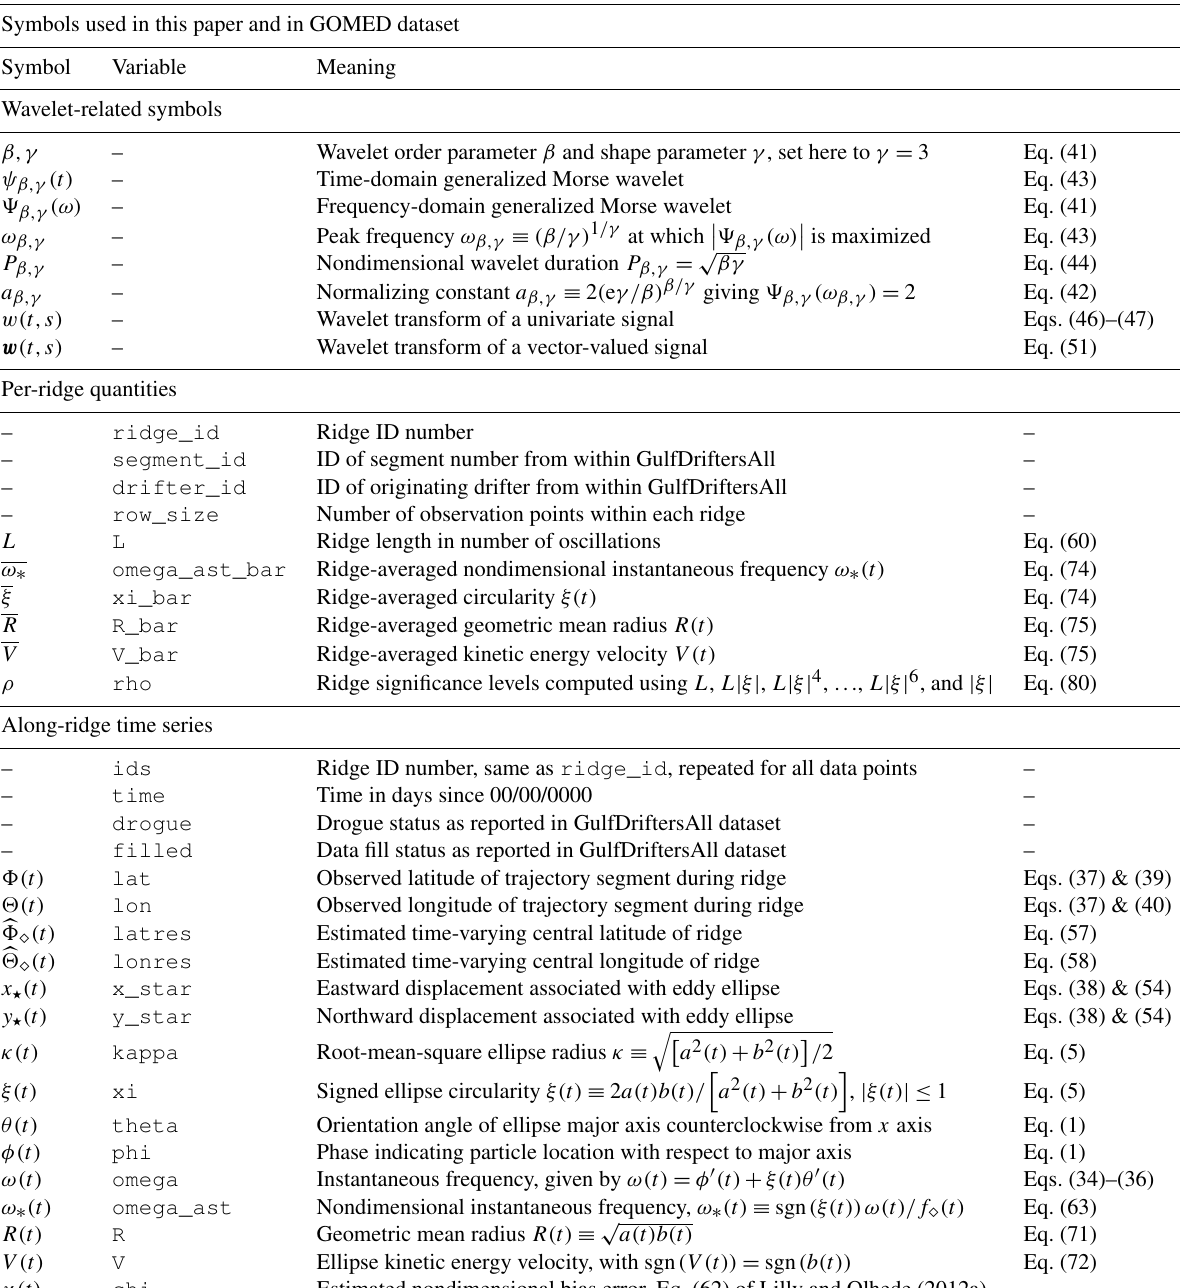
Table A1. Some important symbols used in this paper, together with variables from the GOMED dataset. The quantities in the second and third sections of the table are all the variables appearing in GOMED. Symbols used in this paper and in GOMED